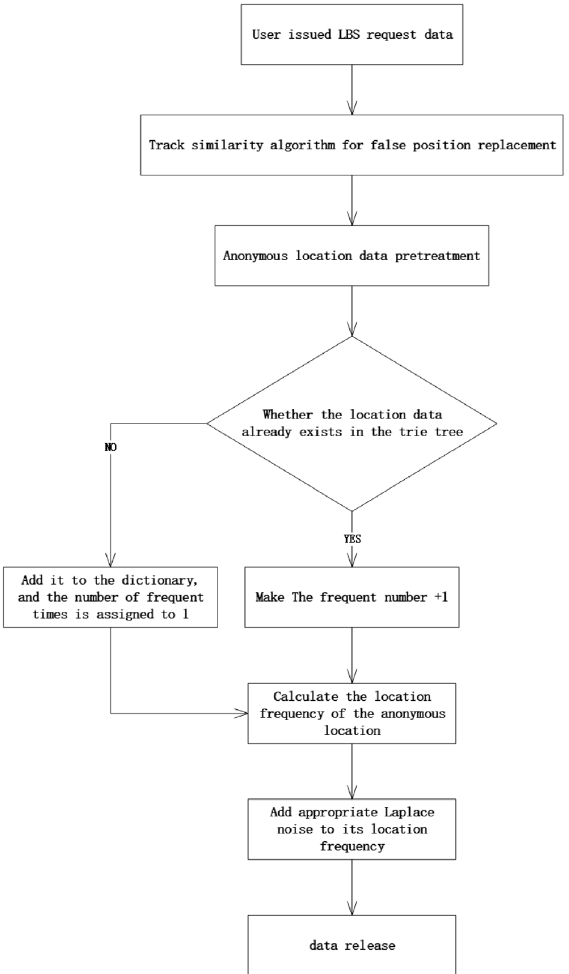
Figure 2. The algorithm flowchart.